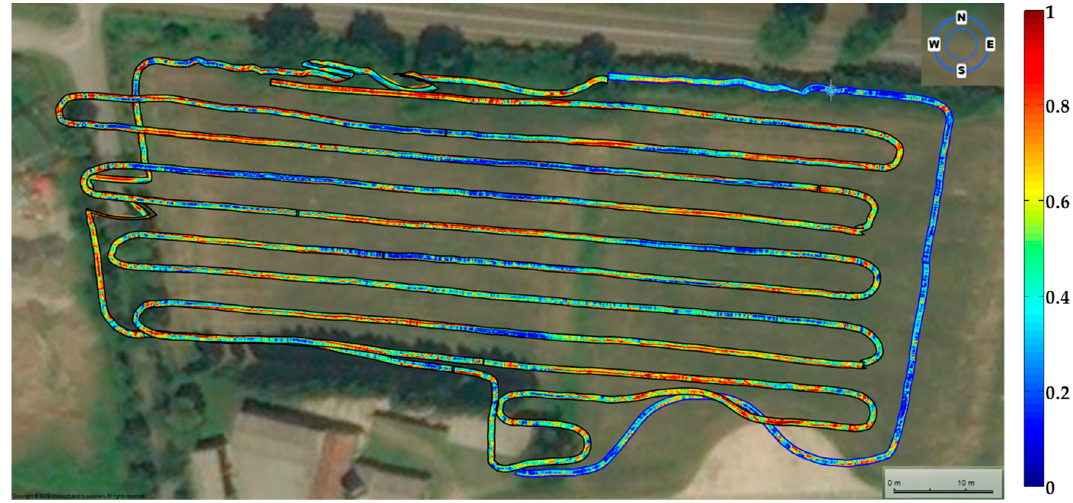
Figure 4. Extracted GPR time slice of the surveyed area, t = 2.8 ns.